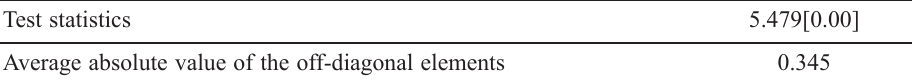
Table 3. Pesaran (2004) test of cross-sectional